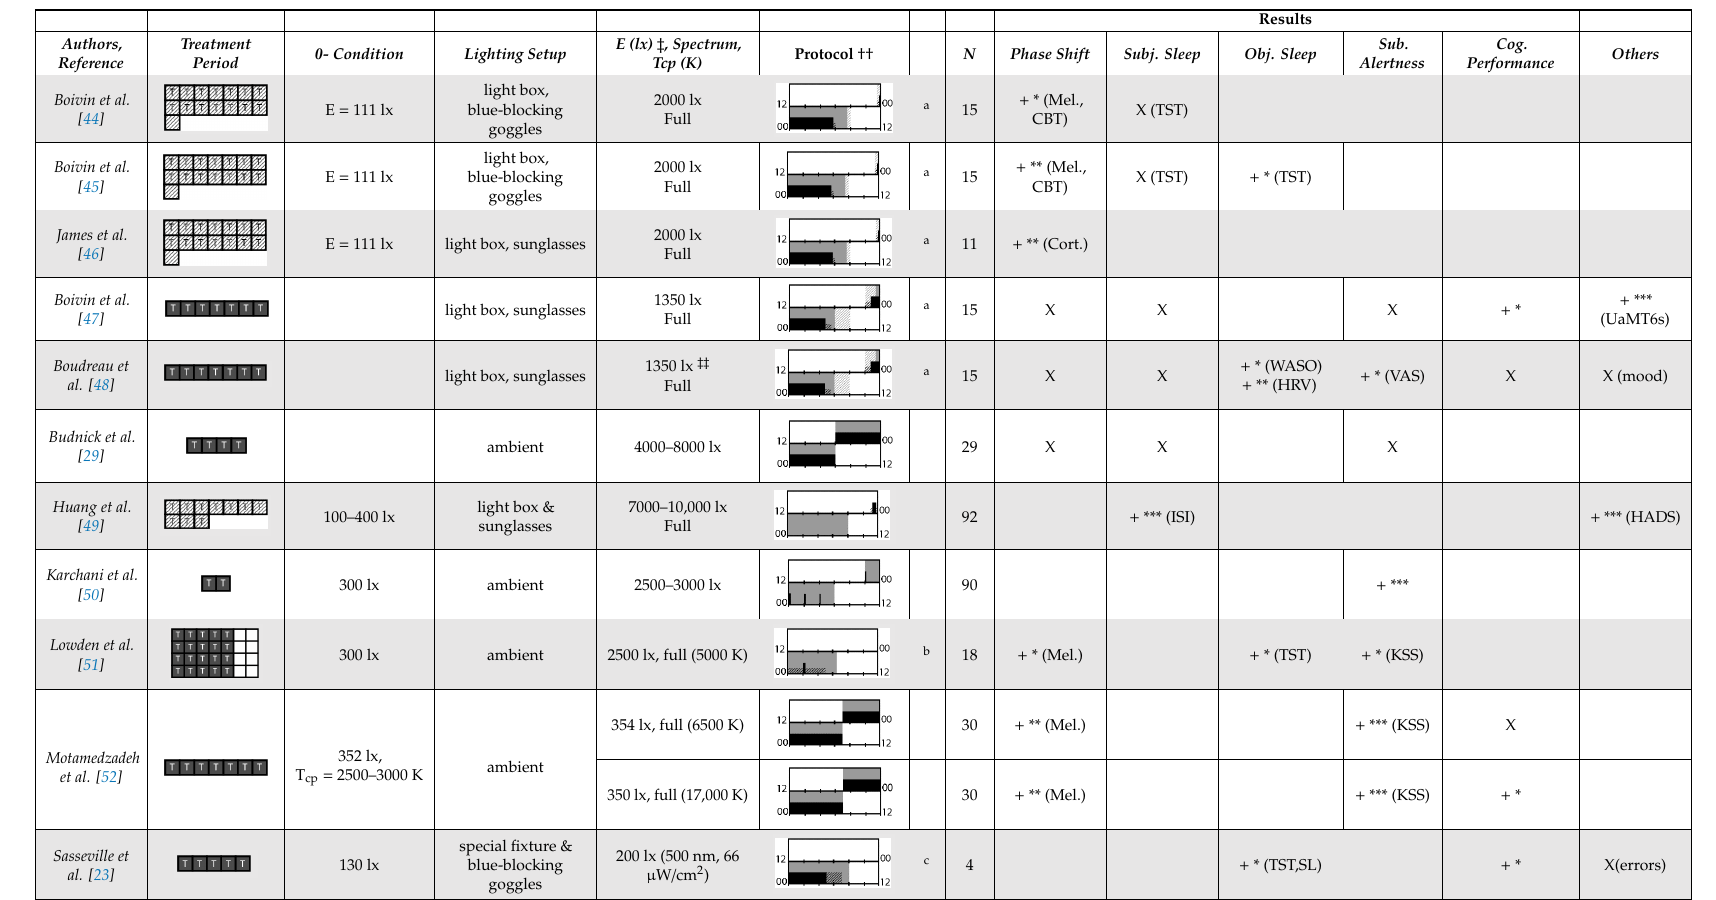
Table A1. Field studies using scheduled light exposure for night-shift workers .